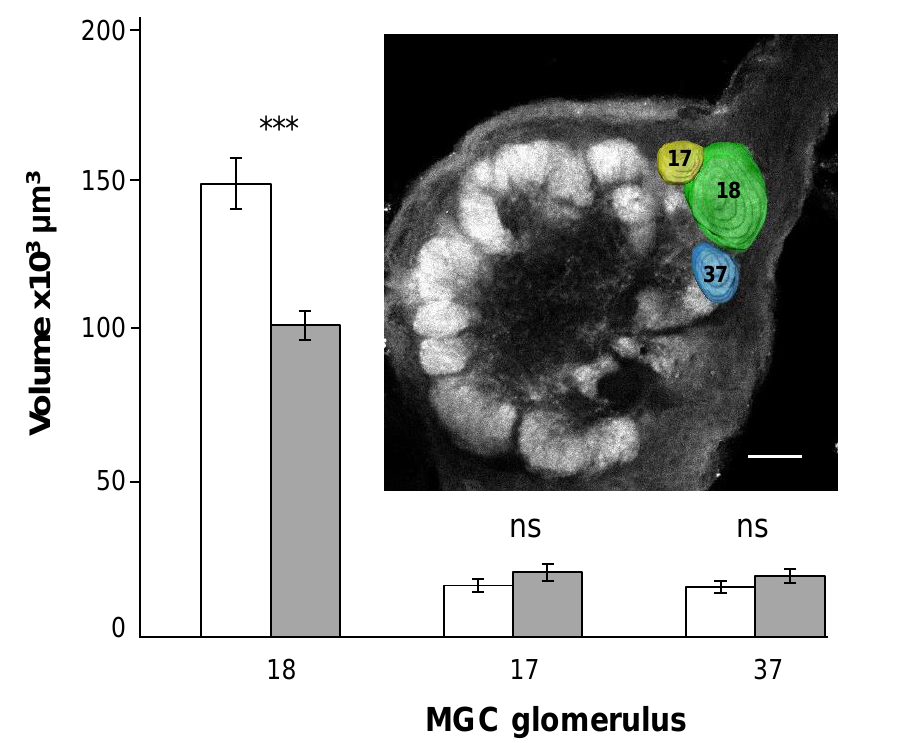
Figure 2. Effects of SlitOR5 knock-out on the macroglomerular (MGC) complex anatomy. Inset: Frontal optical section through the right antennal lobe of an S. littoralis mutant (KO) male with superimposed reconstructions of the three macroglomeruli in color: the cumulus (18) and the two minor MGC glomeruli (17 and 37). Glomerulus 18, also named the cumulus, receives input from neurons responding to the major pheromone component, Z 9, E 11-14:OAc, detected by SlitOR5. Macrogomerulus volume comparison between wild type (WT, n = 12, white bars) and SlitOR5 knock- out (KO, n = 12, grey bars) Spodoptera littoralis males. Glomerulus 18 is significantly smaller in KO individuals. Bars indicate mean volumes ± s.e.m. Scale bar 50 µ m; *** p < 0.0001, ns not